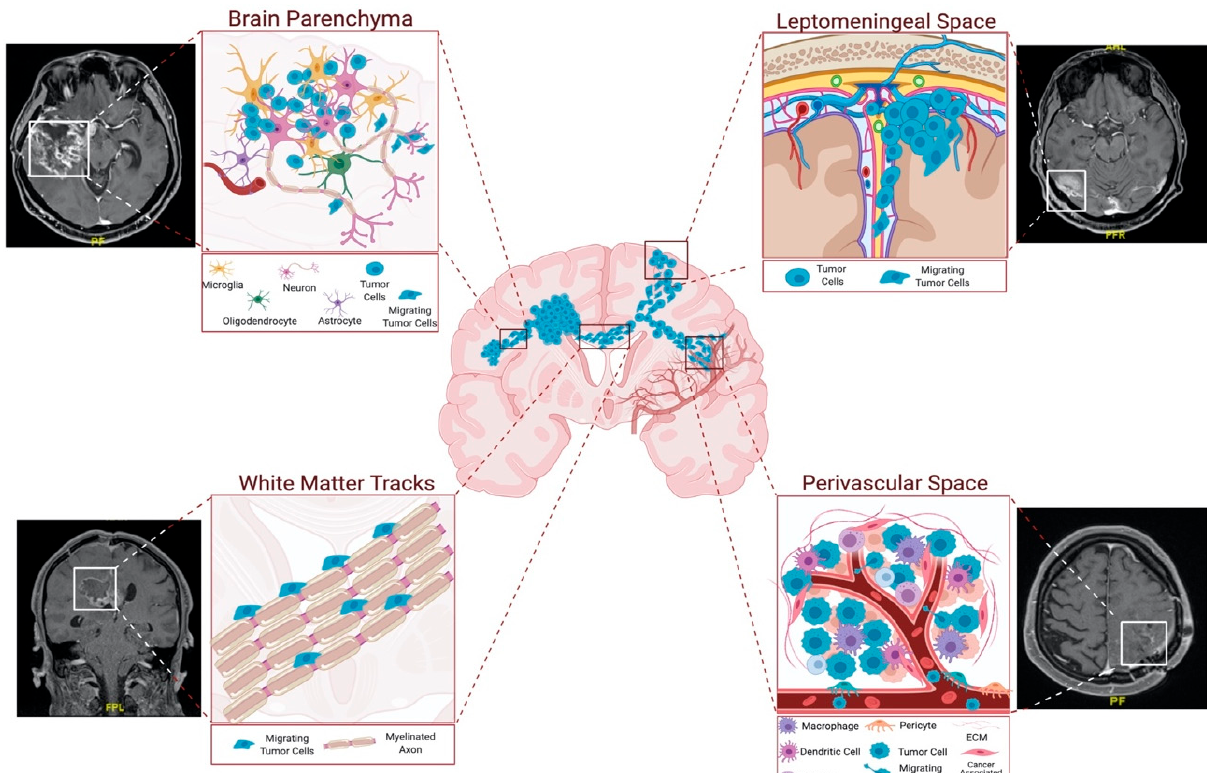
Figure 2 . Routes of glioblastoma cell invasion. Glioblastoma cells generally invade using tracts in parenchyma, white-matter tracts, and leptomeningeal and perivascular spaces. Among these, perivascular space and white-matter tracts are the most preferred routes for glioblastoma invasion. Perivascular space attracts the tumor cells with the presence of blood vessels, which provide oxygen and nutrients. White-matter tracts are composed of myelinated axons, and tumor cells exploit these structures to reach distant locations in the brain. Parenchymal cells facilitate glioblastoma invasion by secreting several factors. Figure generated at Biorender.com, combined with representative MRI images from our clinic.